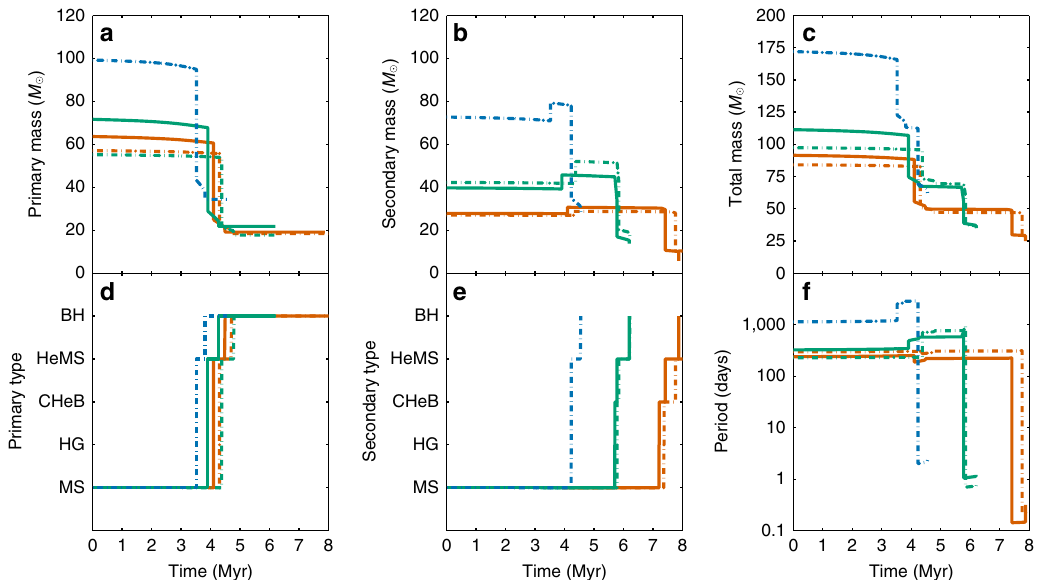
Figure 2 | Typical evolution of BBHs progenitors. Evolution in time of representative GW150914 (blue), GW151226 (orange) and LVT151012 (green) progenitors at 10% solar ( Z ¼ 0.002, solid lines) and 5% solar metallicity ( Z ¼ 0.001, dashed lines). ( a ) The mass of the initially more massive star. The stars lose mass through stellar winds, mass transfer and supernovae. ( b ) The mass of the secondary star. The stars may accrete mass during mass transfer episodes. ( c ) The evolution of the total mass of the binary. ( d ) The evolutionary stage (stellar type) of the initially more massive star as given by Hurley et al. 39 (see Results for definitions). ( e ) The evolutionary stage (stellar type) of the secondary star. ( f ) The orbital period of the binary in days. ST 1 M 1